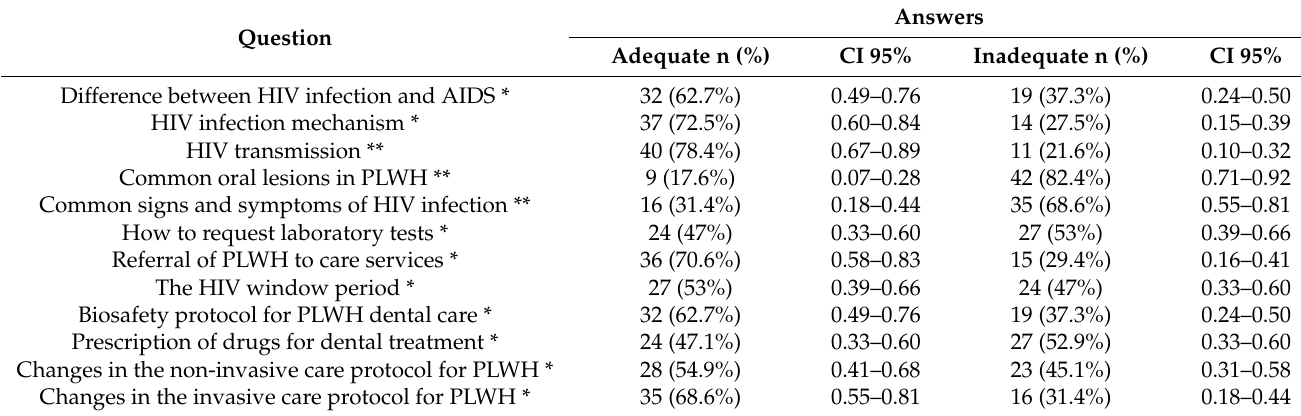
Table 2. Responses of the participants of the present study to the general and specific questions on the oral needs of people living with